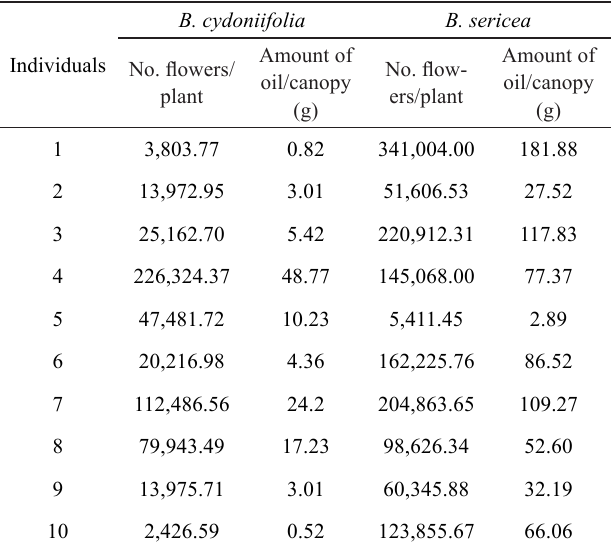
Table 2 . Number of flowers and amount of oil in ten individuals of Byrsonima cydoniifolia and B. sericea (Malpighiaceae) in a cerrado area in the Chapada Diamantina, northeastern Brazil.